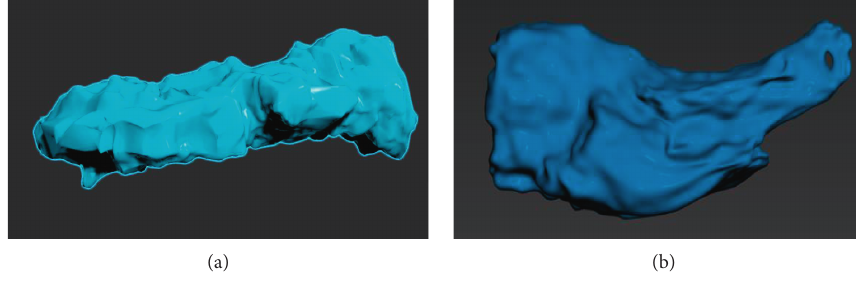
Figure 1: Irregular karst cavities in nature.